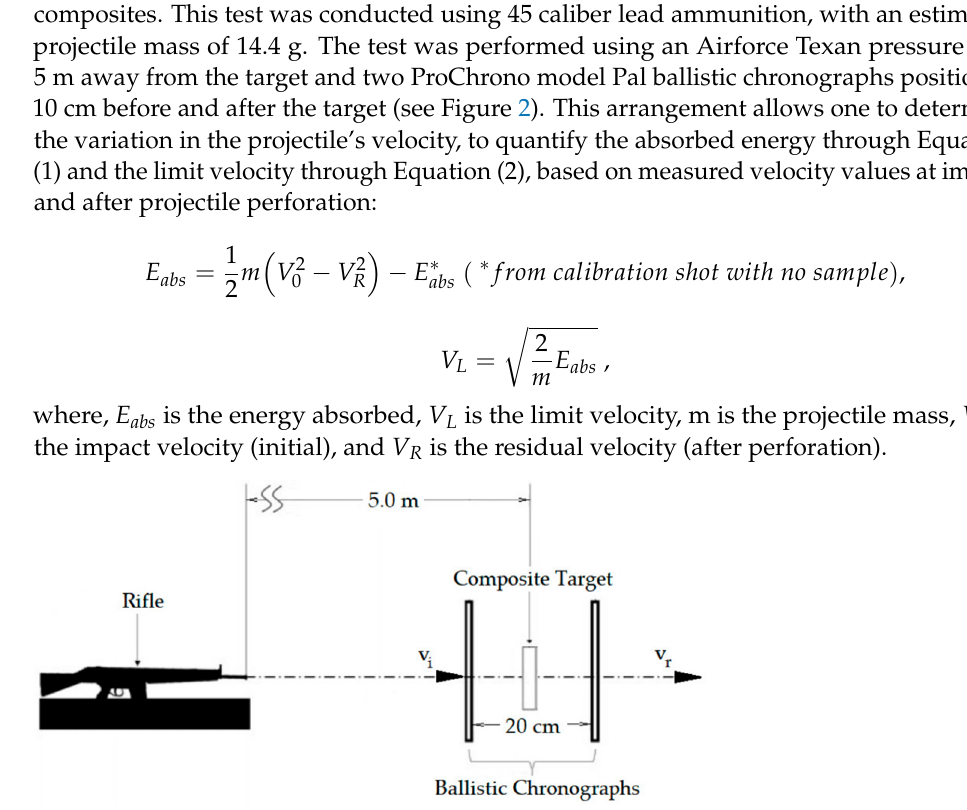
Figure 2. Detection system in the ballistic energy absorption test Figure 2. — Detection system in the ballistic energy absorption test. Adapted from [16].